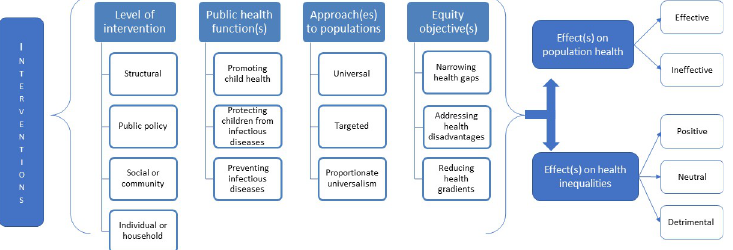
Fig 1. Analytical framework to understand the effect of public health interventions on health inequalities in LMICs [33].